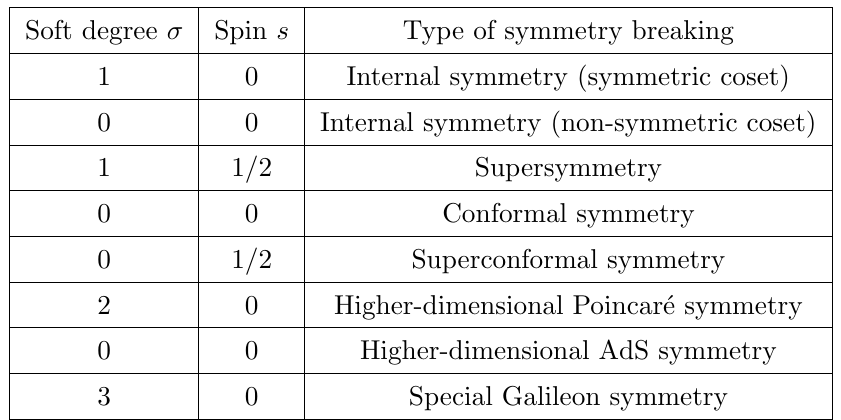
Table 1 . The table lists soft weights (cid:27) associated with the soft theorems A n ! O ( (cid:15) (cid:27) ) as (cid:15) ! 0 for several known cases. The soft limit is taken holomorphically in 4d spinor helicity, see section 3.1 for a precise de(cid:12)nition. Conformal and superconformal breaking is discussed in section 5.3.